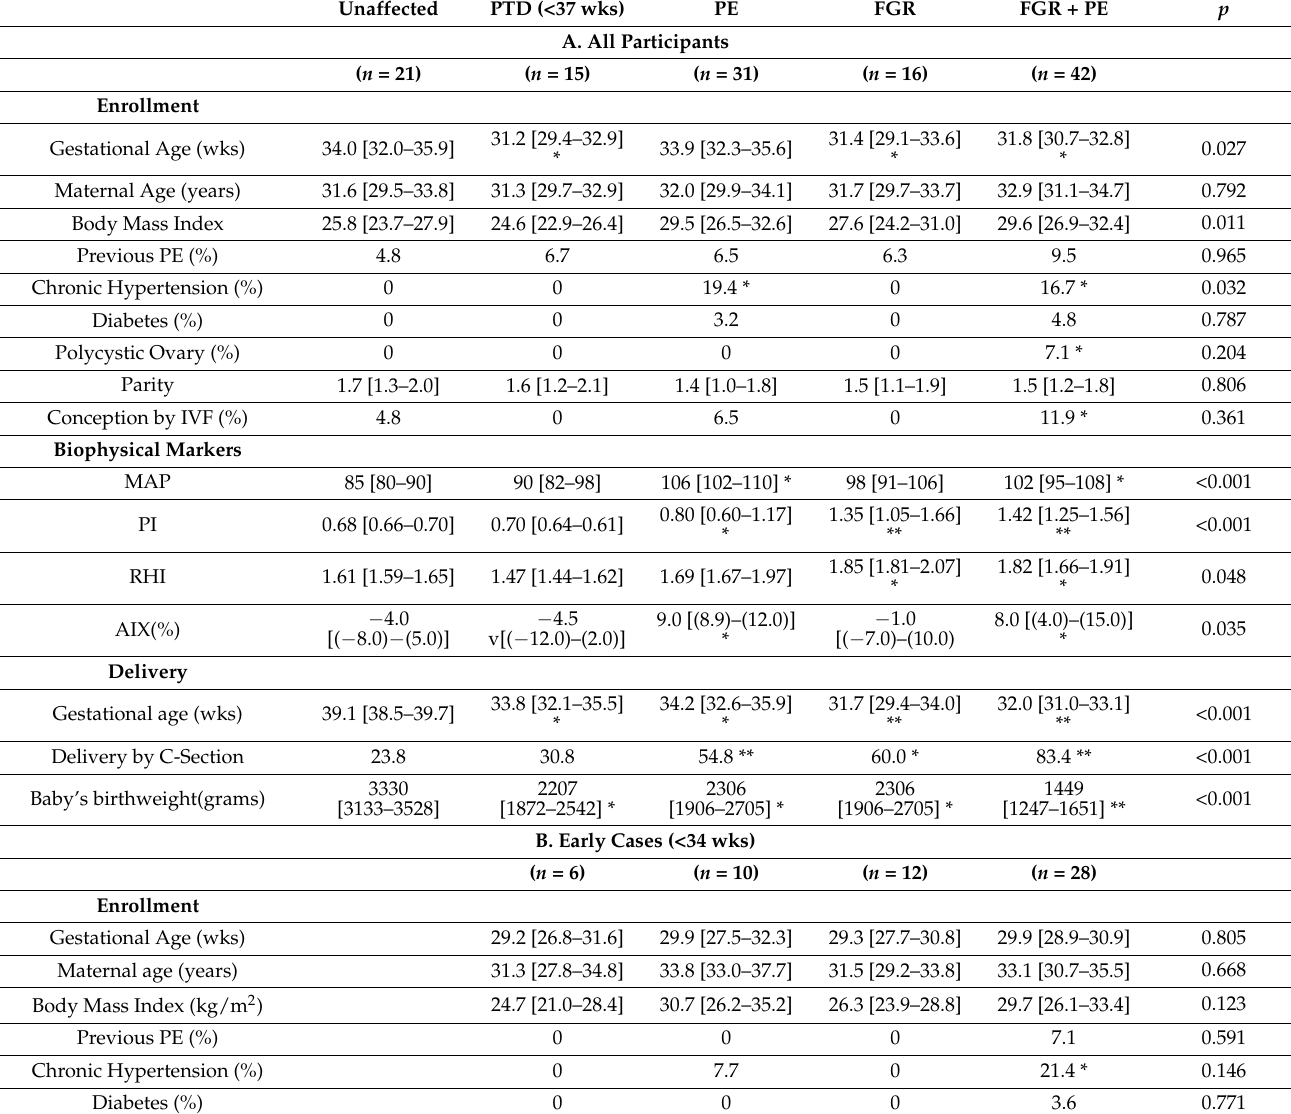
Table 1. Enrolment and delivery characteristics and biophysical